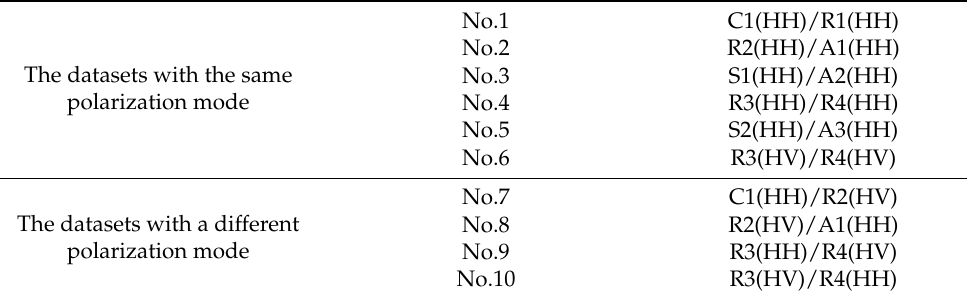
Table 2. The Datasets of The Experiment.